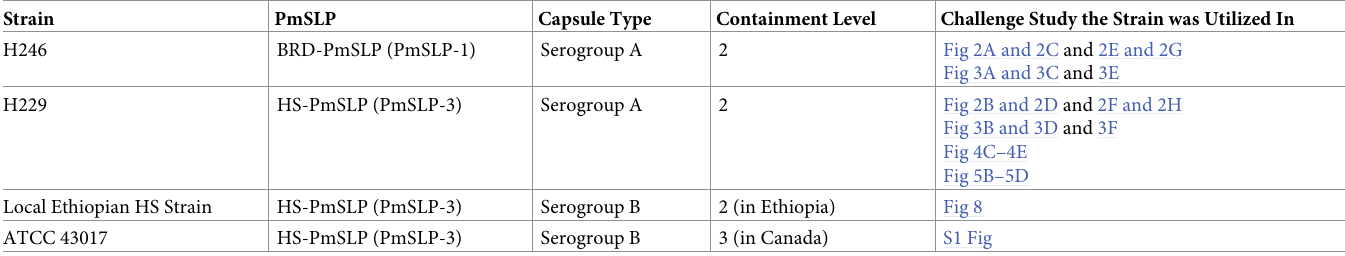
Table 1. Challenge strains of P . multocida utilized in these